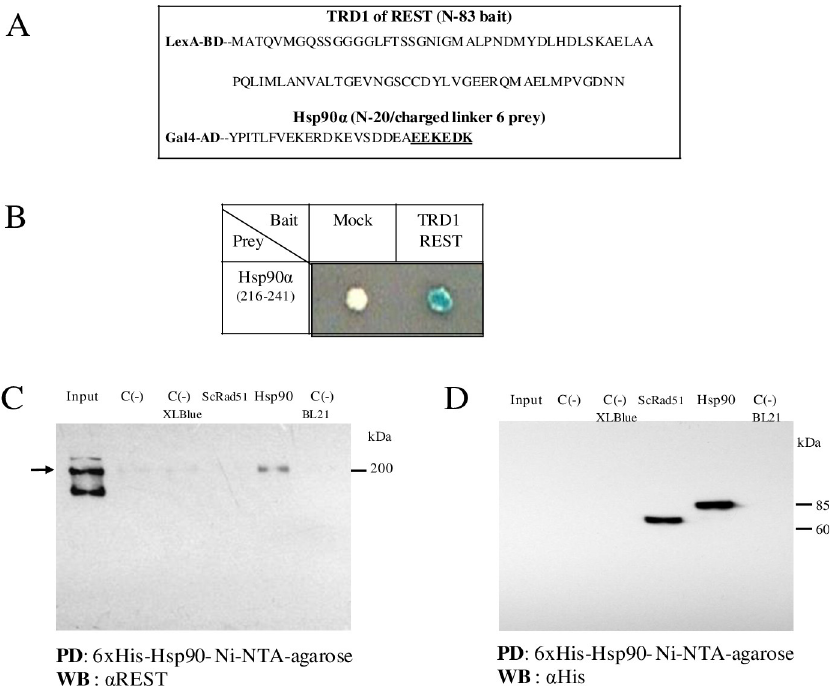
Fig 1. Yeast two-hybrid screen shows that the N-terminus of Hsp90 α interacts with TRD1 of REST. (A) Sequence of TRD1 (N- termini of REST, 1–83 aa), and Hsp90 α N- termini fragment [216–241 aa, including the highly charged linker (236–241 aa indicated in bold and underlined)]. ( B) A representative Hsp90 α prey plasmid (clone 17.52-SK) was transformed into L40 yeast expressing REST bait or empty plasmid (negative control). Transformed yeast were grown on His- /Trp- /Leu- drop out plates + β -X-gal. 17.52-SK is a clone identified through library screening that contained part of the human HSP90 gene ( HS90AA1 ). ( C) His-tag pull-down assays were performed using nuclear protein extracts from synchronized HeLa cells. These extracts were incubated with purified 6xHis-Hsp90 α protein bound to Ni-NTA agarose beads (lane 5). Nuclear protein extracts from synchronized HeLa cells were used as Input and as a negative control to rule out non-specific binding by Ni-NTA-agarose (lane 2). Additional negative controls used were bacterial extract (BL21 or XL Blue, lane 3 and 6) and 6xHis-ScRad51 (lane 4, Sc: S . cerevisiae ). The autoradiogram shows bound protein after elution from Ni-NTA agarose beads and separation by 8% SDS-PAGE, followed by immunoblotting with anti-REST antibody (Millipore-Upstate 07–579). The molecular weights are indicated to the right of panels C and D (kDa). The arrow indicates the position of the REST endogenous dimer. ( D) Immunoblotting of a His-tag pull-down assay using anti-His tag antibody. PD: pull-down. WB: western